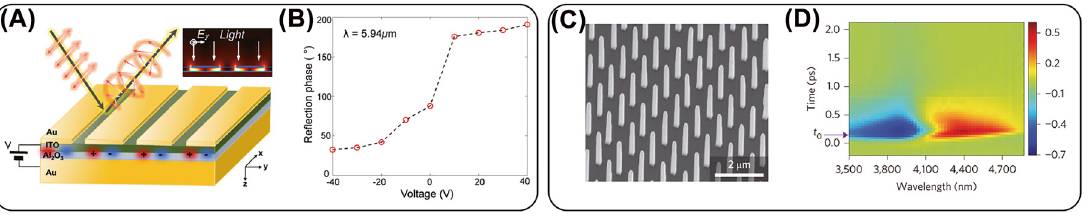
Figure 6: (A) Illustration of an electrically tunable metasurface for phase and polarization control using ITO thin film between two metal layers. The inset shows the distribution of electric field on resonance. (B) Phase control as a function of gating voltage at wavelength of 5.94 μ m. (A) and (B) reprinted from [185], Copyright 2016 American Chemical Society. (C) SEM image of an ITO nanorod array (ITO-NRA) with 1 μ m periodicity and 2.6 μ m height. (D) Transient absorption measurement of the ITO ITO-NRA. The spectral map of the change of optical density ( Δ OD) around the long-localized surface plasmon resonance (LSPR) measured by ultrafast NIR-pump-MIR-probe experiments. (C) and (D) reprinted from [186], Copyright 2016, Springer